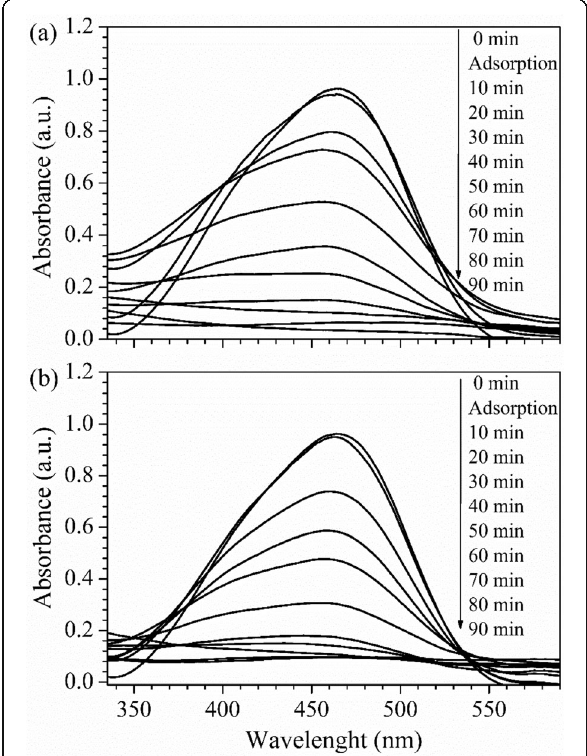
Fig. 10 UV-Vis spectra of the degradation of MO (4 × 10 -5 M, pH = 7.0) using the catalysts: (a) pristine TiO 2 and (b) 2TiMA-ET